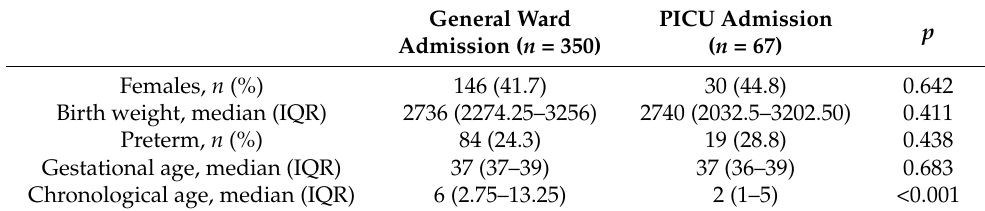
Table 1. Patient demographics.